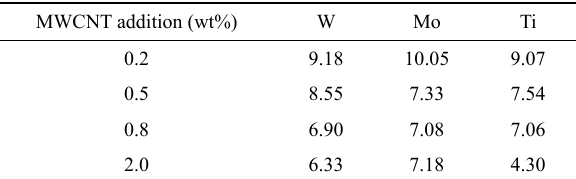
Effect of the MWCNT addition on the element content of the binder